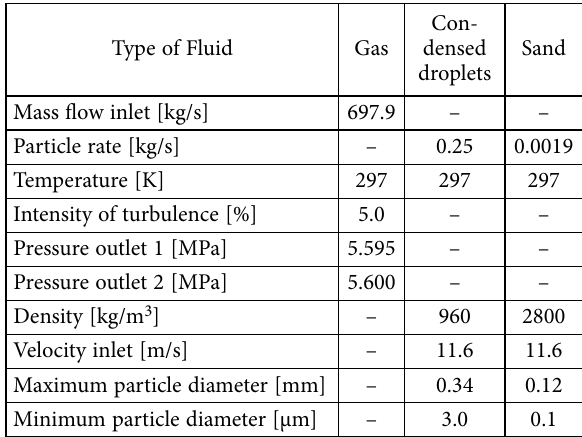
Table 2. Parametersused in CFD analysis of multiphase